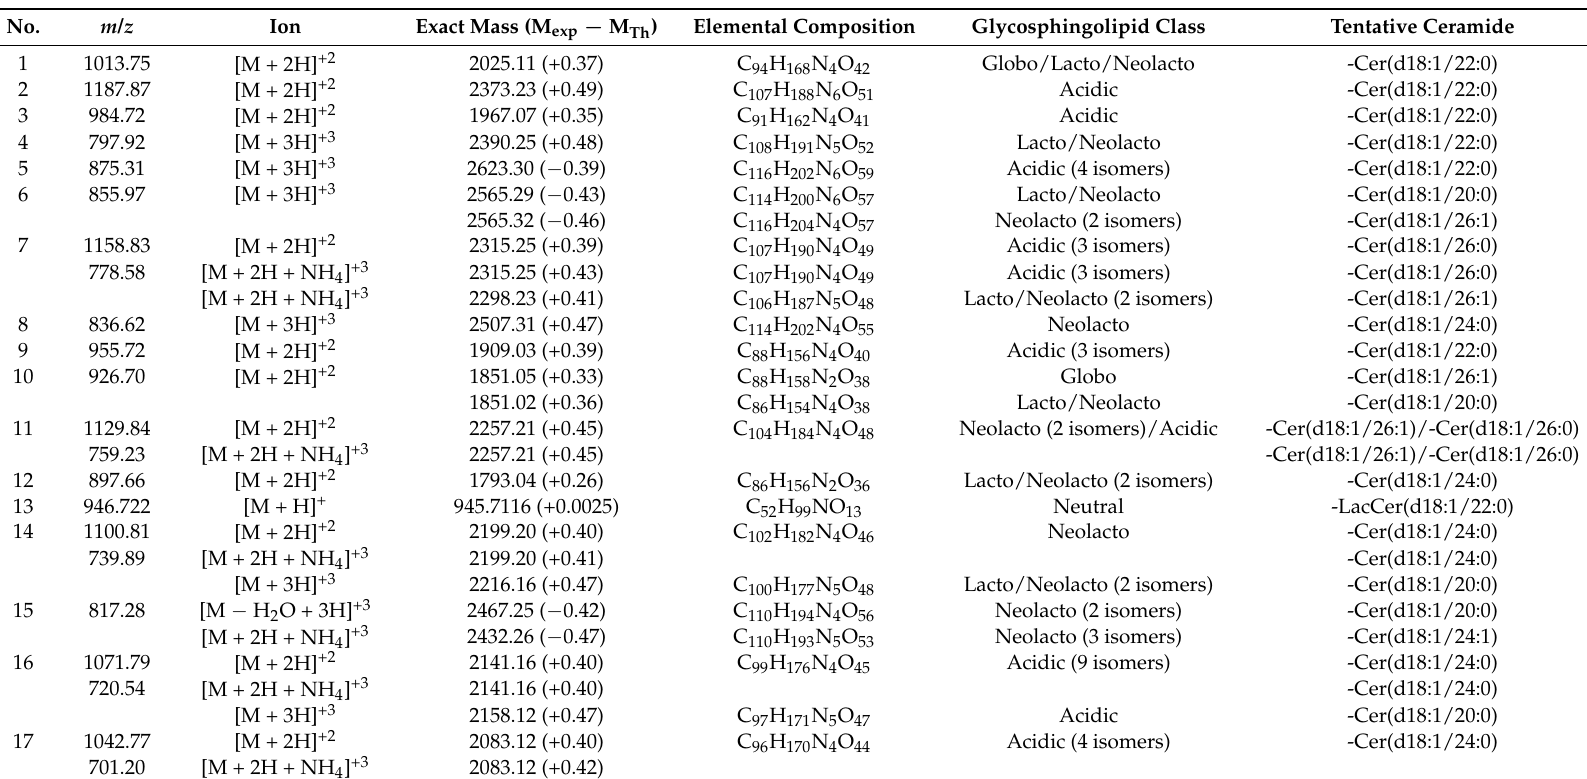
Table 6. Values of m / z from positive ionization that are tentatively ascribed to glycosphingolipid species according to the neutral mass value and the LipidMaps database (http://www.lipidmaps.org). The elemental composition that closely matches the experimental mass was chosen amongst those annotated in the LipidMaps database. M exp is the exact mass calculated from the experimental m / z value, and M Th is the theoretical exact mass corresponding to the proposed elemental